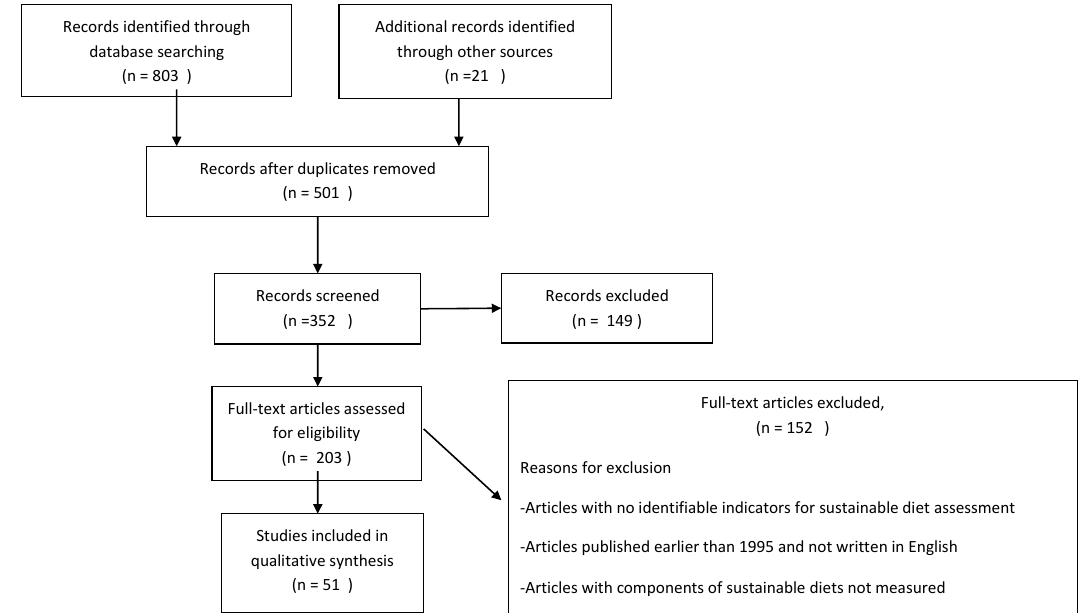
Figure 1. A flow chart of how the articles were selected and included in the review.